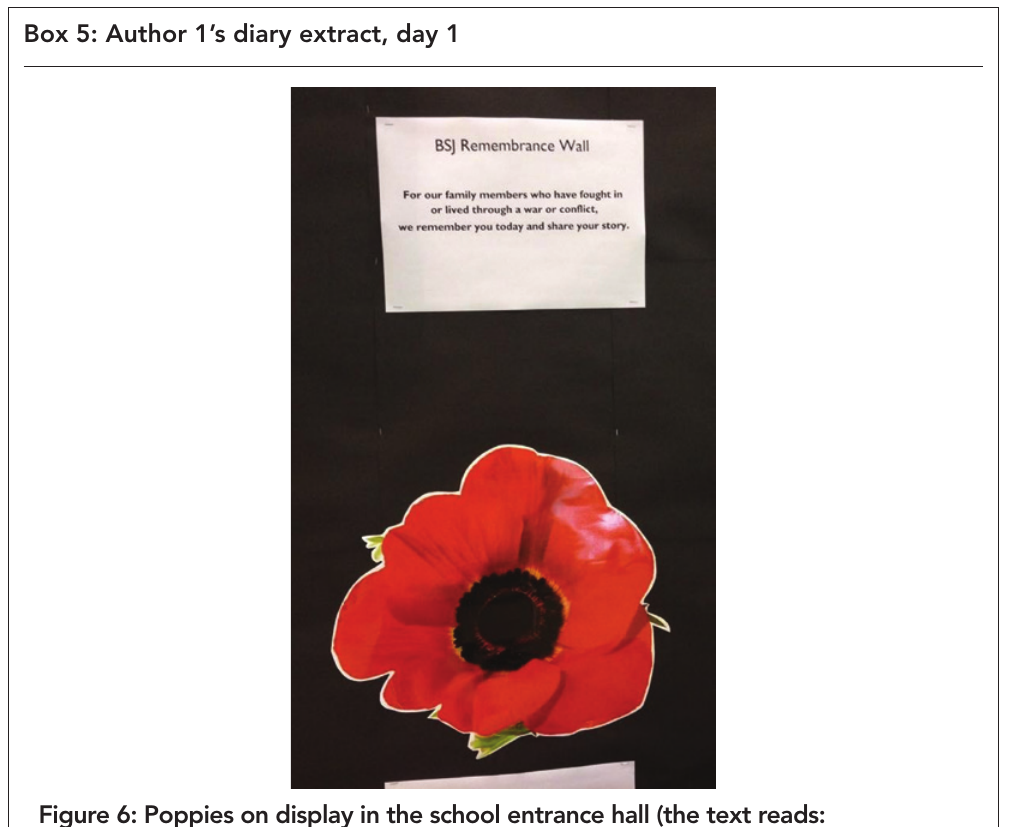
figure 6: poppies on display in the school entrance hall (the text reads: ‘for our family members who have fought in or lived through a war or conflict, we remember you today and share your story’) (Source: elisabeth barratt Hacking, 2015) Today a group of students took me on a tour of the school. As we approached one of the entrance halls[,] huge boards of students’ work and red poppies were on display (see Figure 6). It seemed incongruous to see poppies and student memories of WW1 so far from Europe, and the poppy fields of Northern France in a school in Indonesia with so many local students. The students explained that they had collected war memories from their older family members and friends then presented written memories and photographs alongside images of poppies, the symbol of WW1. It was moving to see memories of friends, families and nations who were once former enemies displayed side by side. I realised that Remembrance Sunday was